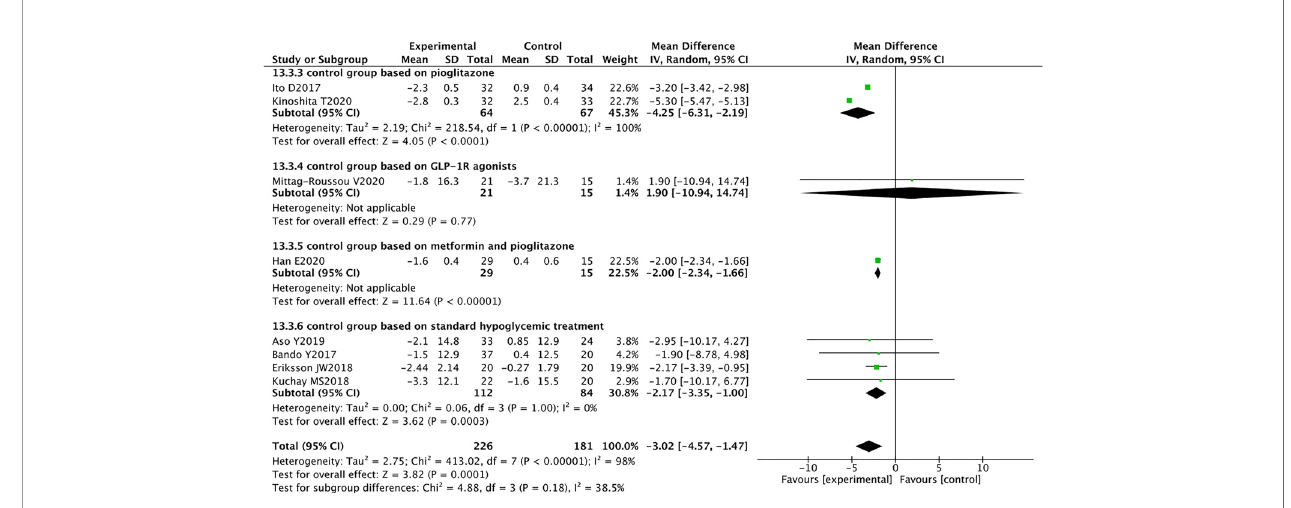
FIGURE 7 | Meta-analysis of body weight level comparisons between SGLT2 inhibitors and the control group based on the